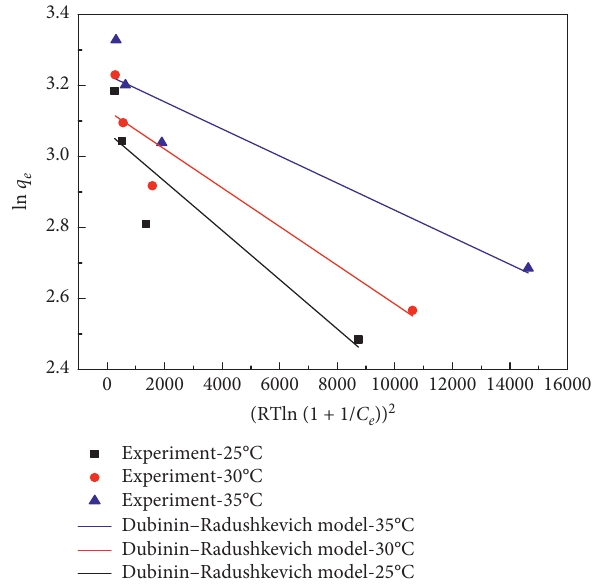
Figure 14: D–R isotherm plots for the uptake of ammonium on the EMRZ.